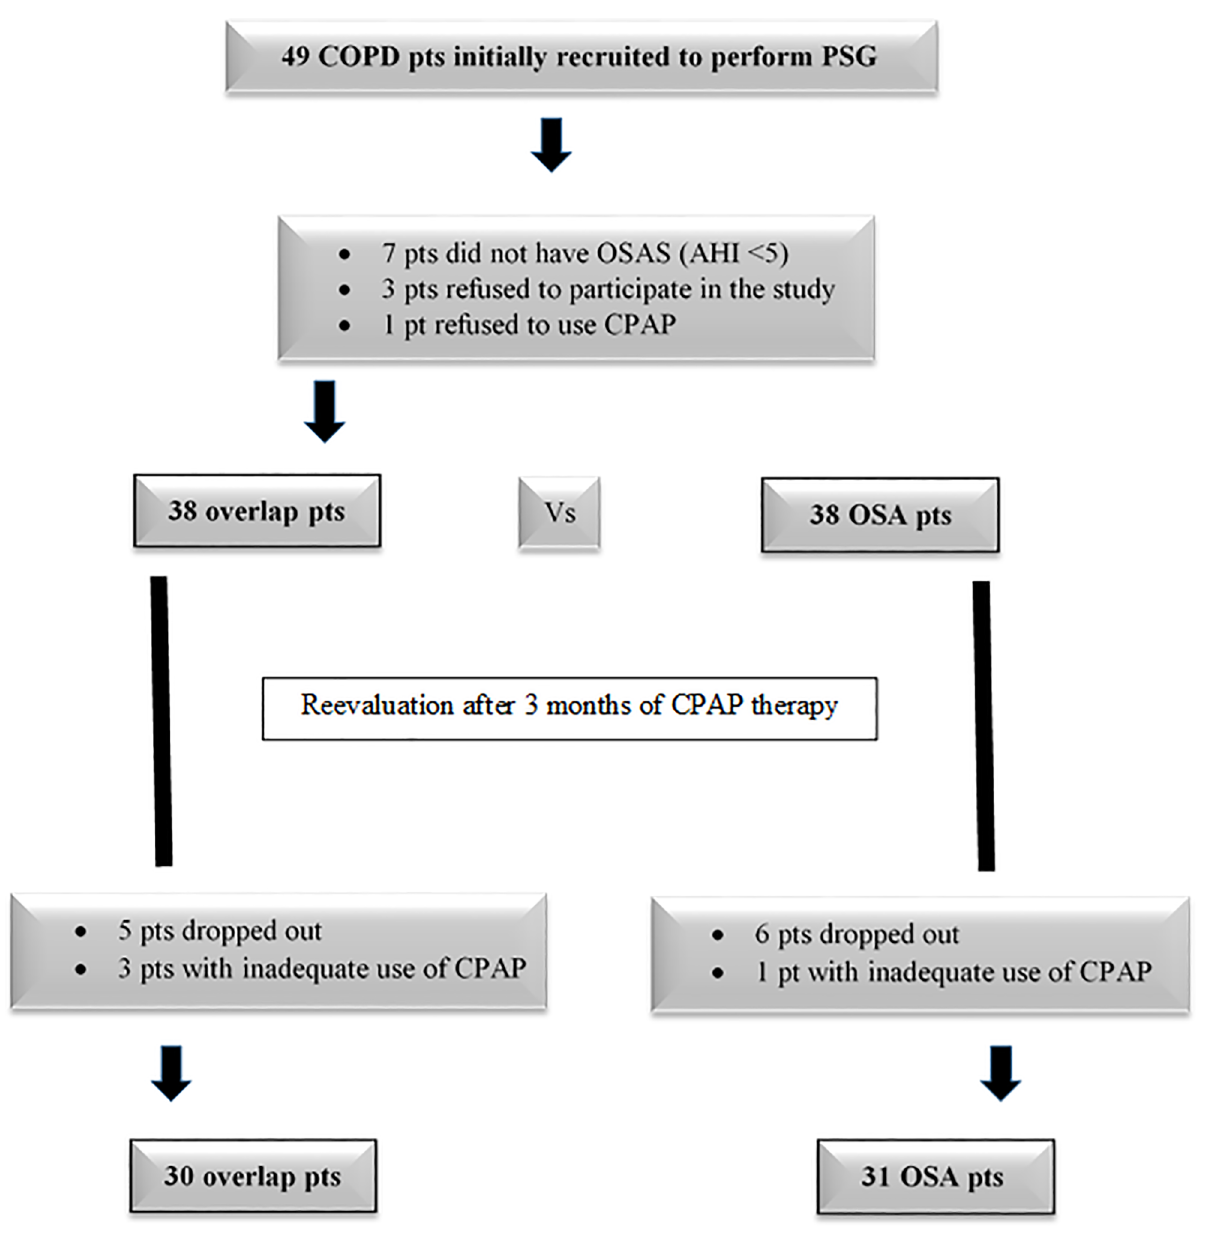
In the univariate analysis none of the scores in questionnaires correlated with AHI (ESS: p = 0.680, FSS: p = 0.212, HADS-A: p = 0.240, HADS-D: p = 0.577). Furthermore, in the multi- variate analysis only male gender and BMI correlated positively with AHI (p = 0.046, and p = 0.039, respectively) “Fig 3”, whereas age and degree of airways obstruction—as expressed by FEV —did not (p = 0.457, and p = 0.761, respectively). During the reassessment, 5 overlap 1 and 6 OSA patients dropped out. Furthermore, 3 overlap and 1 OSA patients were excluded because of inadequate use of CPAP ( < 4 hours per night) “Fig 1”. The residual AHI